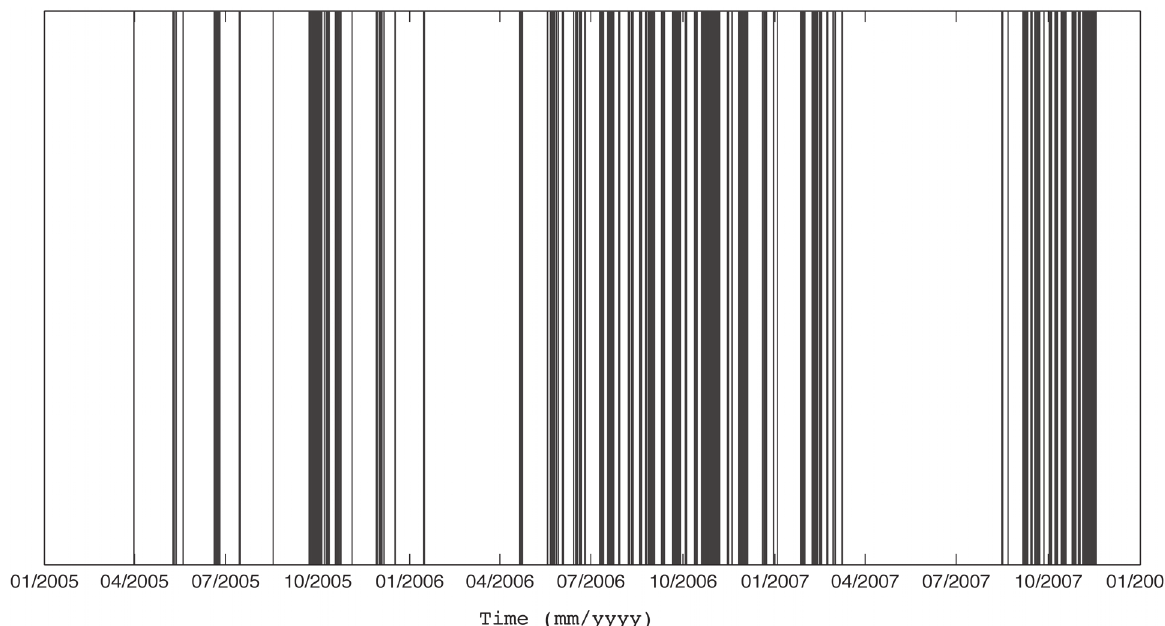
Figure 6 - Ephemeral dunes occurrence. The lines represent images where dunes could be visually identified at the backshore. The time series began on March 3 of 2005 and ended on November 17 of 2007.